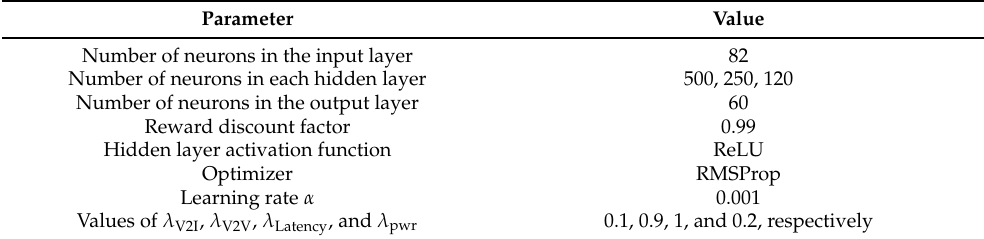
Table 2. DQN framework parameters.